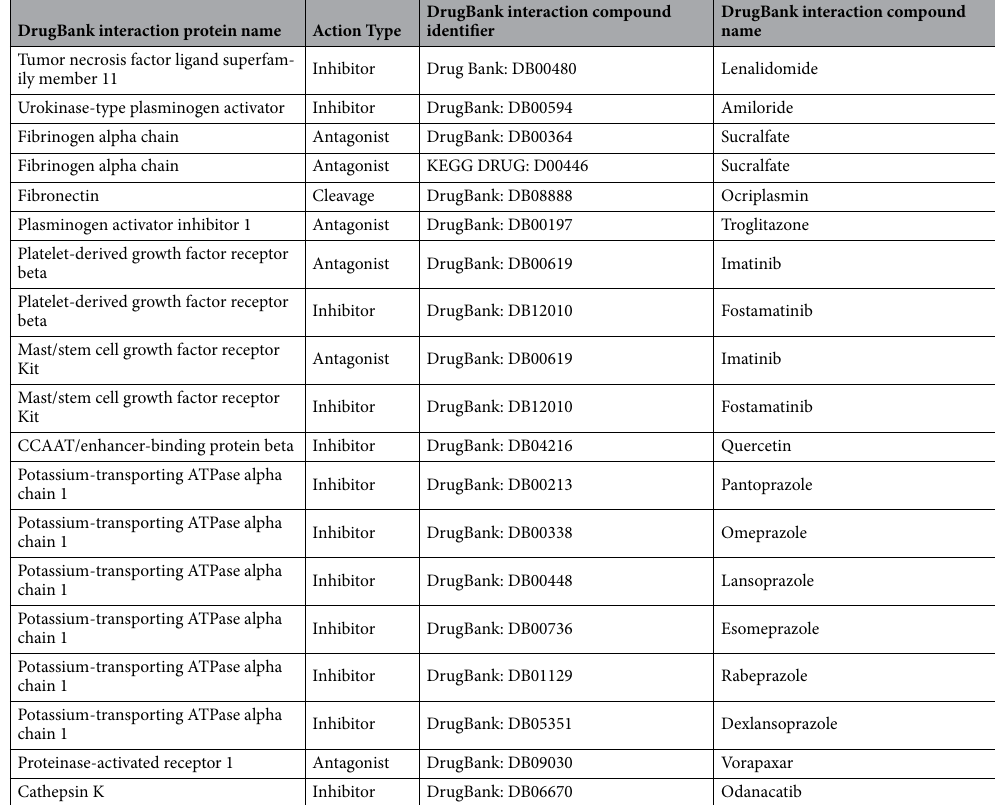
Table 1. Drugs and compounds targeting survival genes and their correlated targets derived from